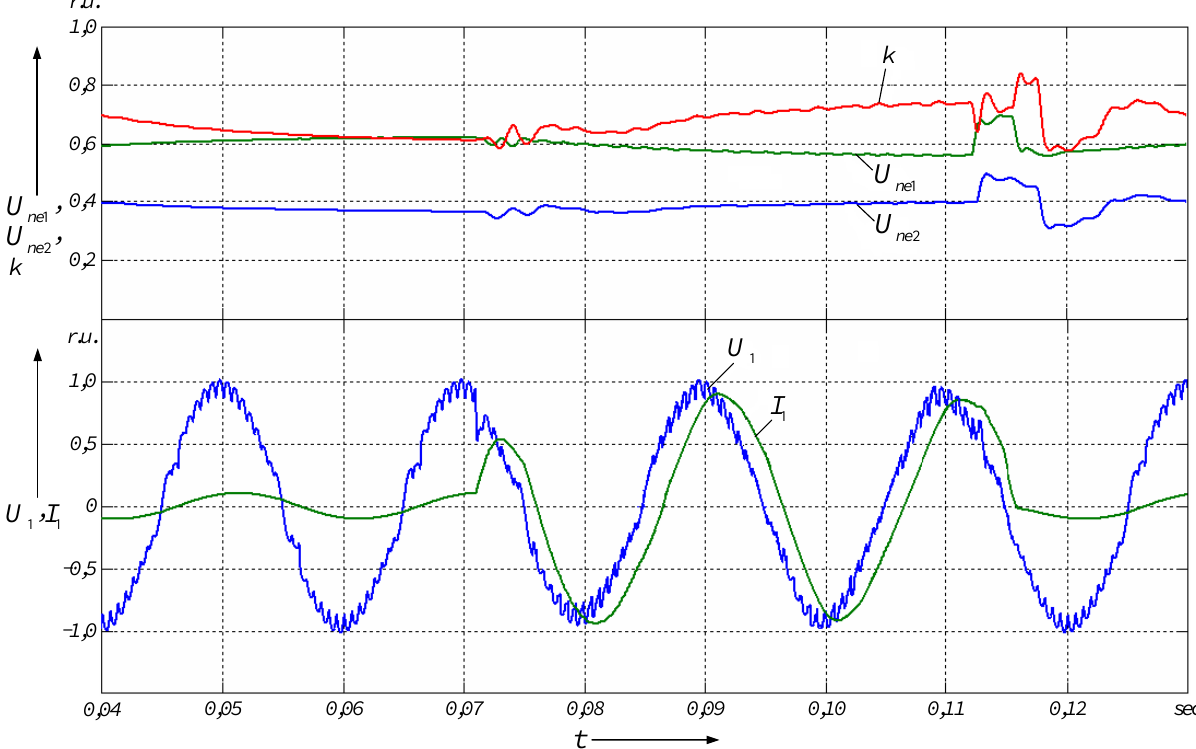
Figure 9. Load voltage and current waveforms of MCS when changing load power while stabilizing output electrical parameters of MCS by means of DC excitation winding circuit